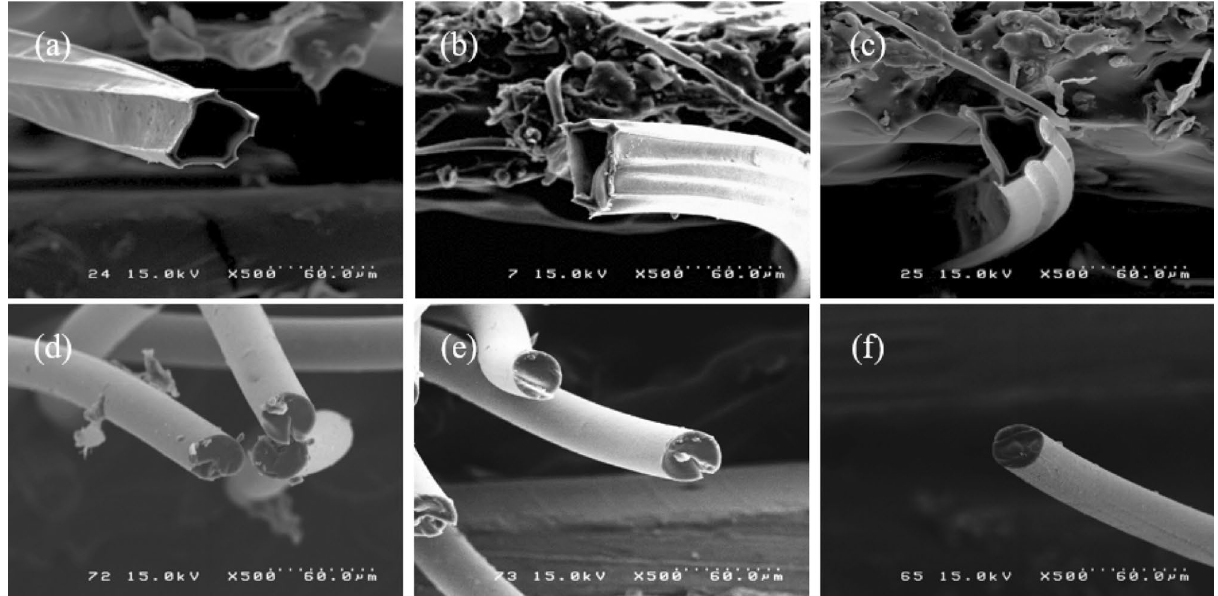
Figure 11. Polyethylene-based carbon fibers prepared from partially drawn HDPE fibers and partially drawn LLDPE fiber with a sulfonation pressure of 5 bar at 130 °C for 3.5 h, 2.5 h ( a ) CH0.6, ( b ) CH7, ( c ) CH18, ( d ) CL1.1, ( e ) CL10, and ( f )